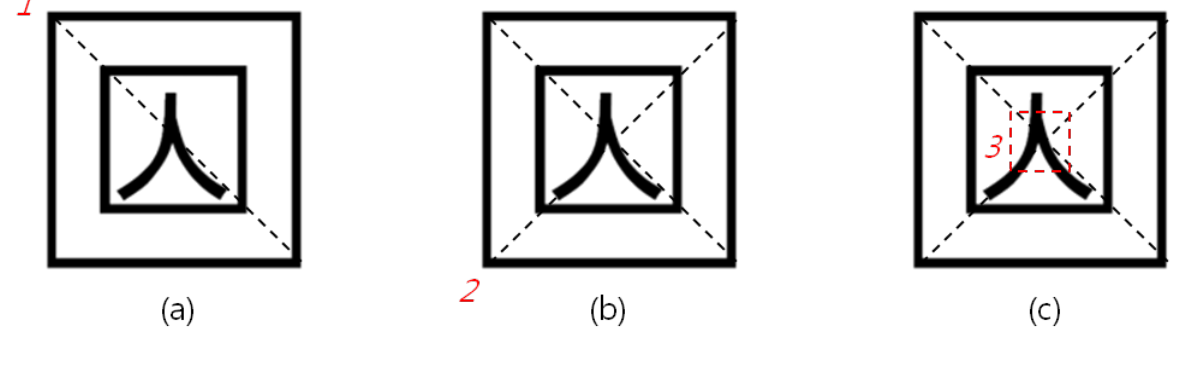
Figure 7. Extraction of a marker‟s focal